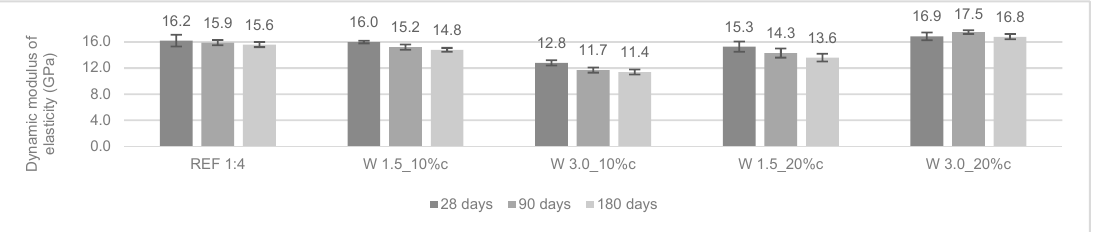
Figure 5. Dynamic modulus of elasticity of the cement mortars.